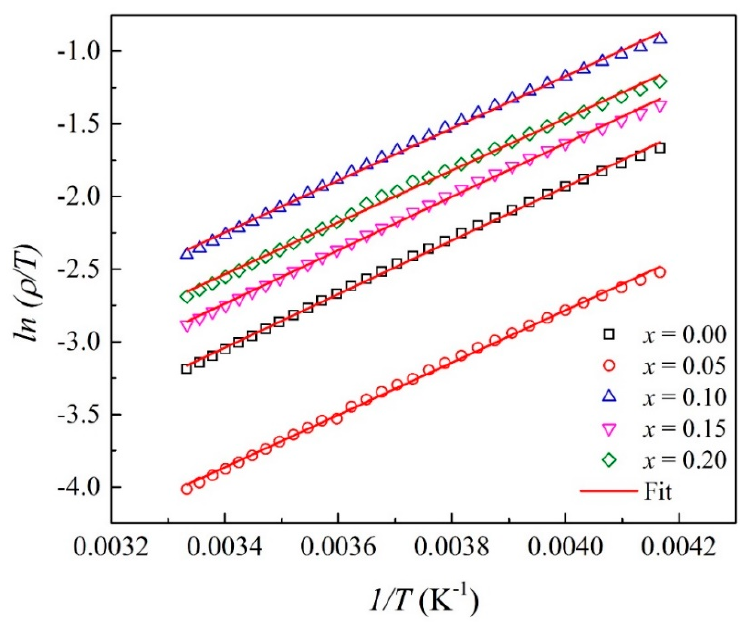
Figure 5. Fitting of resistivity curves of (1- x ) LCMO: x NiO composites by Equation (3).